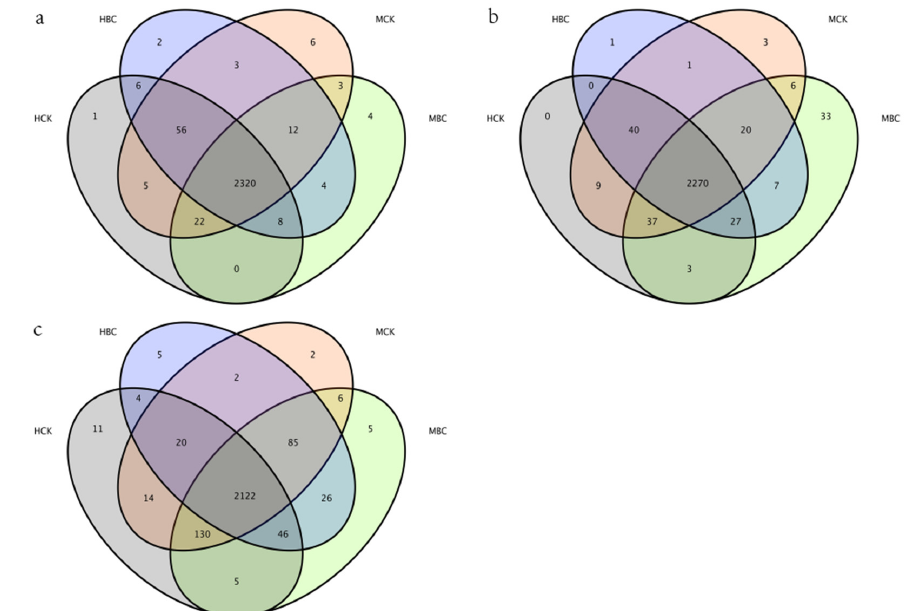
Figure 2. Venn diagram of common and unique OTUs present in microbial communities at different conditions. HBC means the biochar treatment in Huanghuanzhan, HCK means the control treatment in Huanghuanzhan, MBC means the biochar treatment in Meixiangzhan2, MCK means the control treatment in Meixiangzhan2; ( a ) panicle initiation stage; ( b ) heading stage; ( c ) maturity stage.